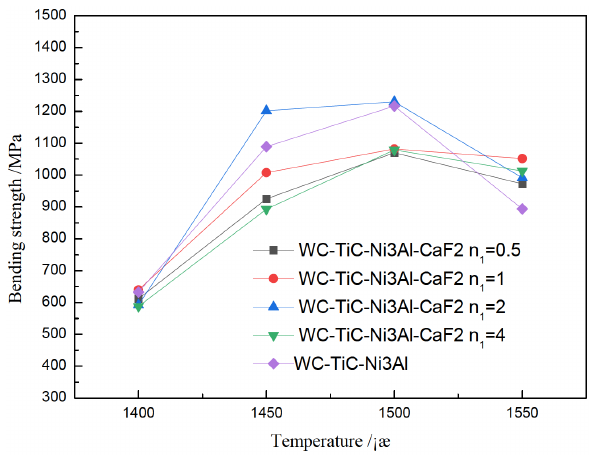
Figure 6: Effect of Temperature on the transverse rupture strength of sintered